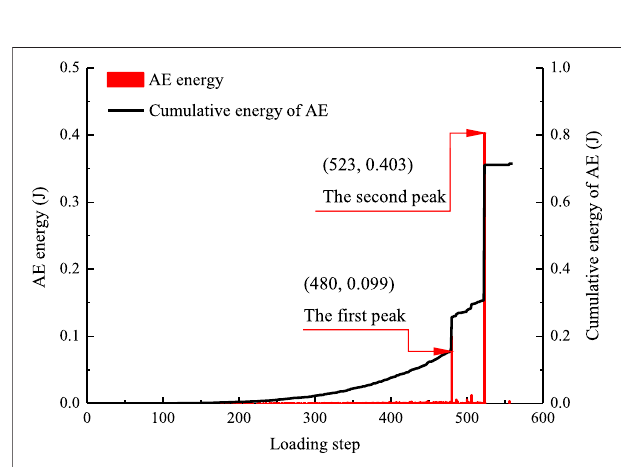
FIGURE 12 | AE energy curve of anchored rock with the negative Poisson ’ s ratio